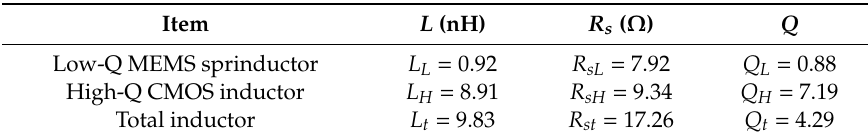
Figure 2. Readout circuit of proposed inductive accelerometer with digital output. Table 1. Inductor parameters at 1.2 GHz.